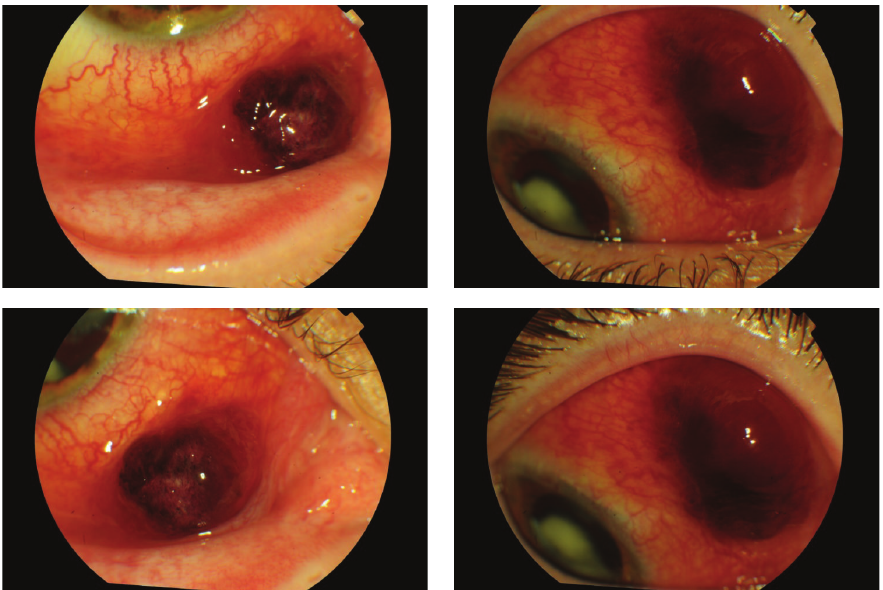
Figure 1: Preoperative biomicroscopy.